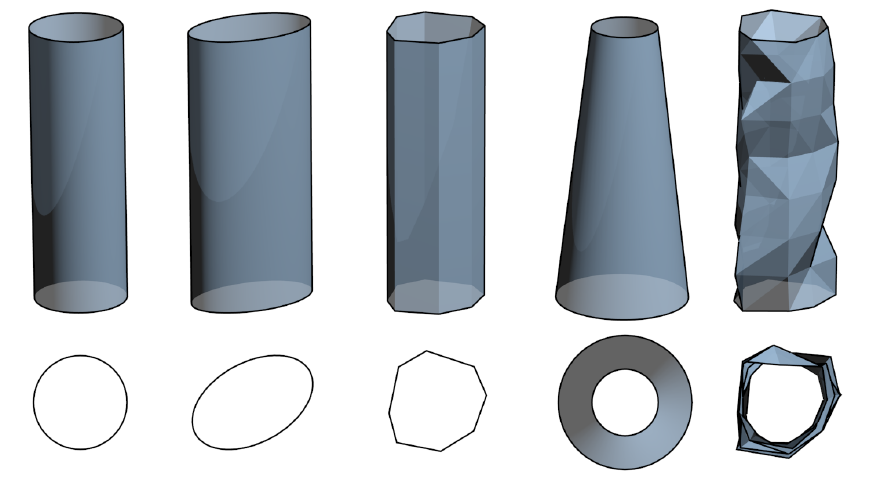
Figure 1. Geometric primitives. From left to right: circular cylinder ( circyl ), elliptic cylinder ( ellcyl ), polygon cylinder ( polcyl ), truncated circular cone ( cone ) and polyhedron ( trian ). ( Top ) Perspective side view; ( bottom ) orthographic top